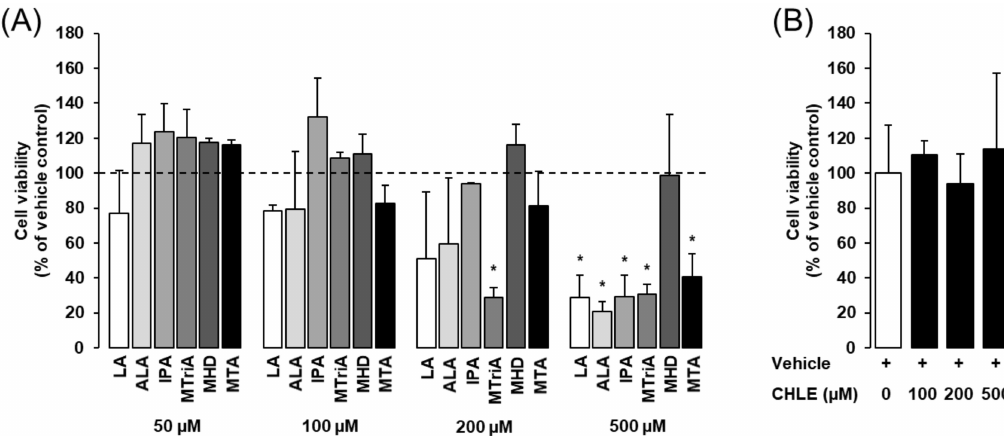
Figure 1. E ff ects of isolated fatty acids ( A ) and Conidiobolus heterosporus lipid extract (CHLE) ( B ) on cell viability of Fao cells. Fao cells were treated either without (vehicle) or with di ff erent concentrations of linoleic acid (LA), α -linolenic acid (ALA), isopalmitic acid (IPA), 12-methyltridecanoic acid (MTriA), 14-methylhexadecanoic acid (MHD), 12-methyltetradecanoic acid (MTA) or CHLE for 24 h, and cell viability was measured by the MTT assay. Bars represent means ± SD of three independent experiments. ( A ) The dashed line indicates the vehicle control ( = 100%). * p < 0.05 compared with vehicle